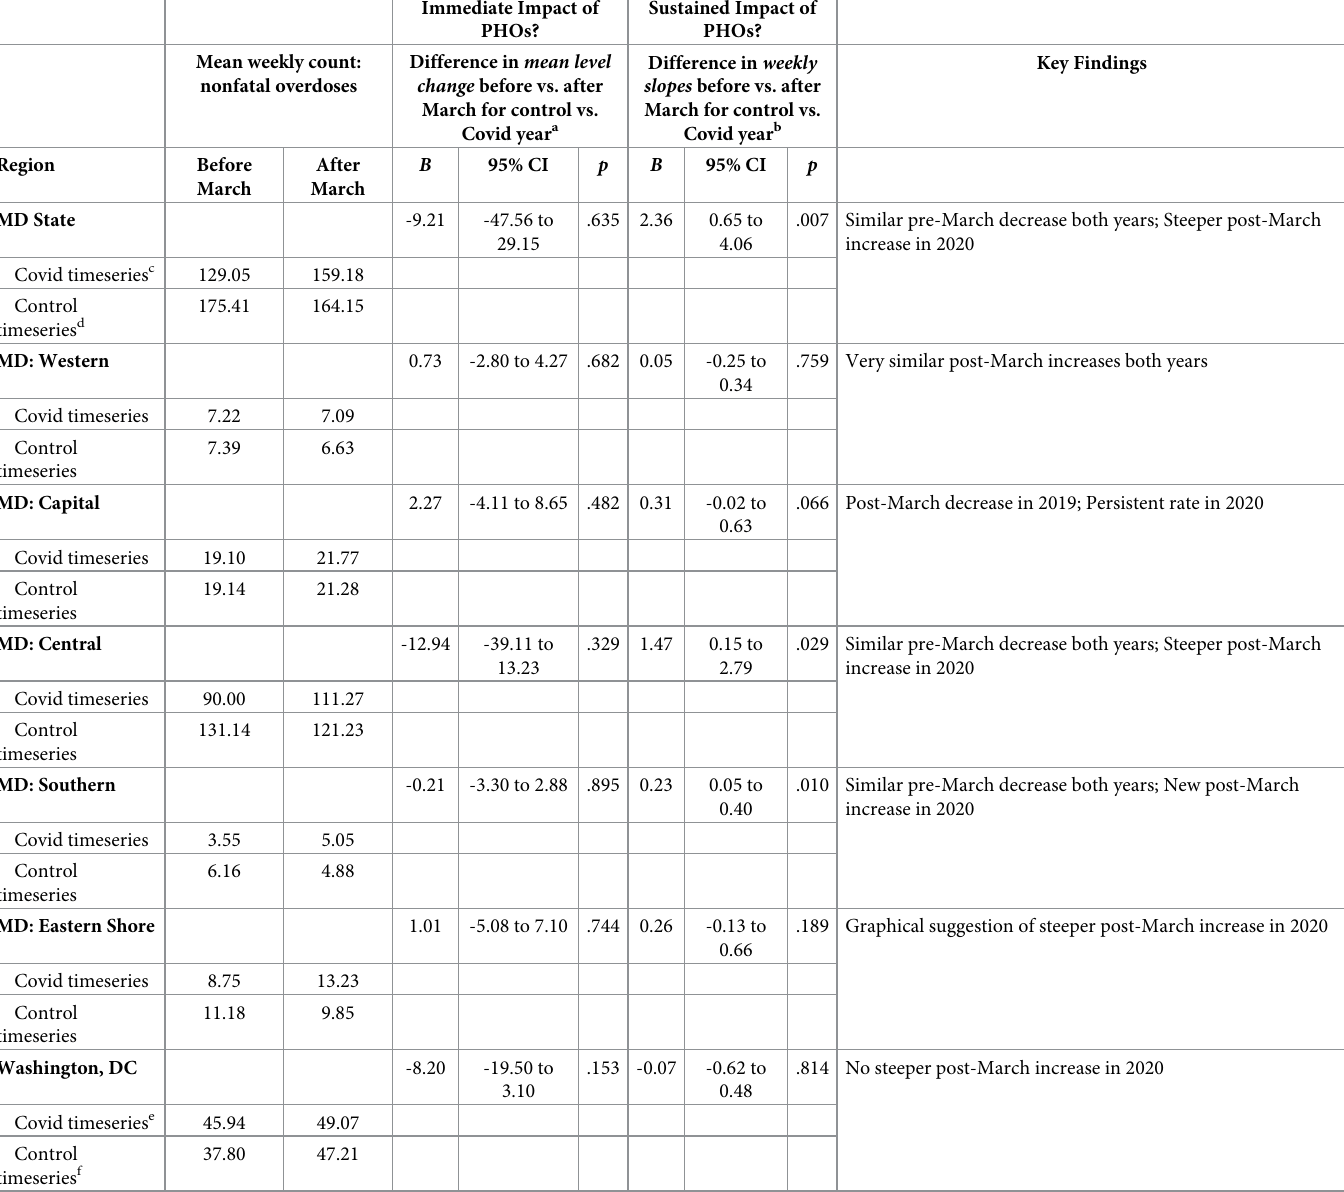
Immediate Impact of PHOs?